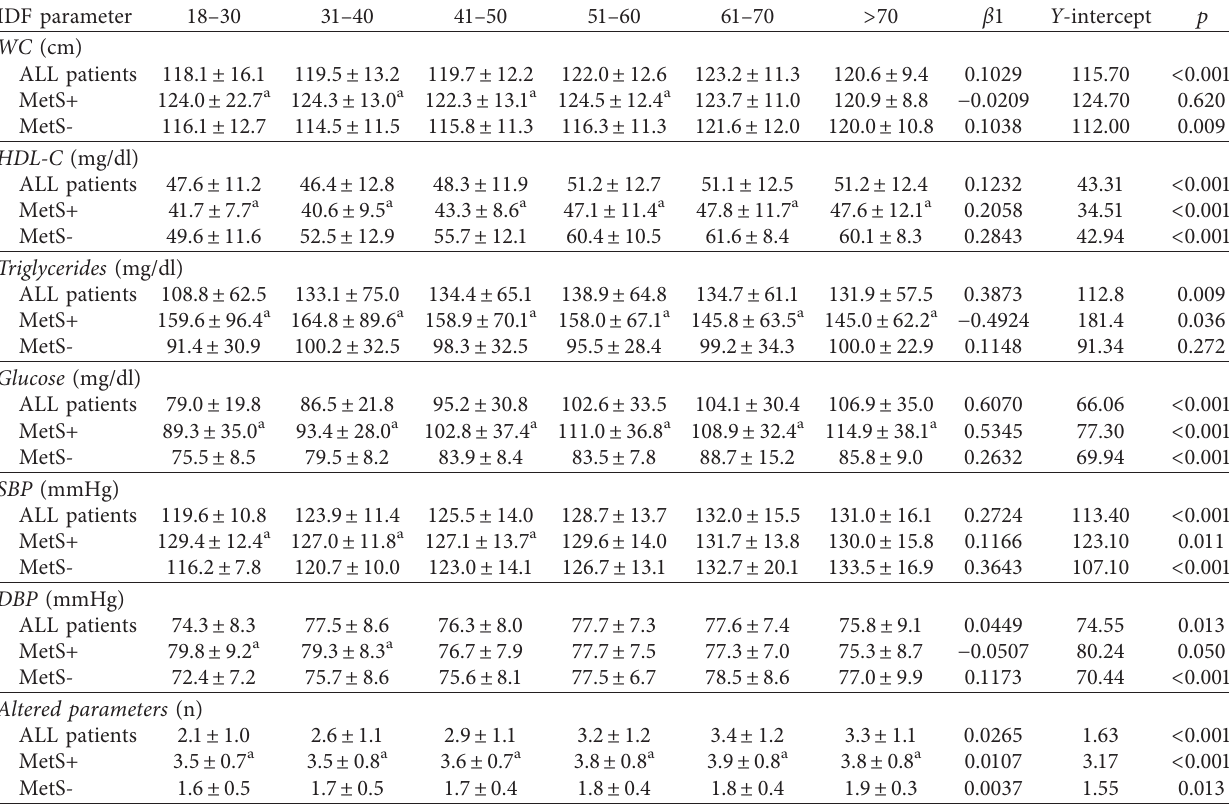
Table 2: Values of the parameters adopted as criteria by IDF for the diagnosis of metabolic syndrome (waist circumference, dyslipidemia, hyperglycaemia, and hypertension) and number of the altered parameters in accordance with the cut-offs established by IDF in the entire obese population of our study and in the patients with or without metabolic syndrome, subdivided among age ranges.